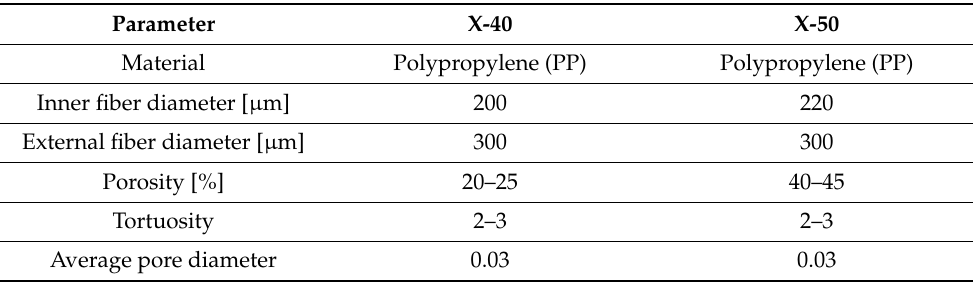
Table 1. Data for X-40 and X-50 2.5” X 8” Liqui-Cel ® Extra-flow contactor modules as provided by manufacturers